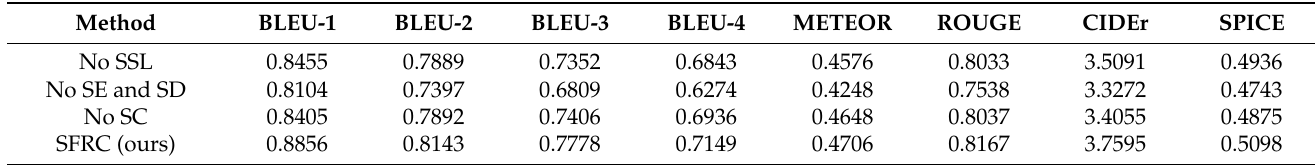
Table 10. Comparison of evaluation metric scores of methods for removing different components on UCM-Captions dataset.